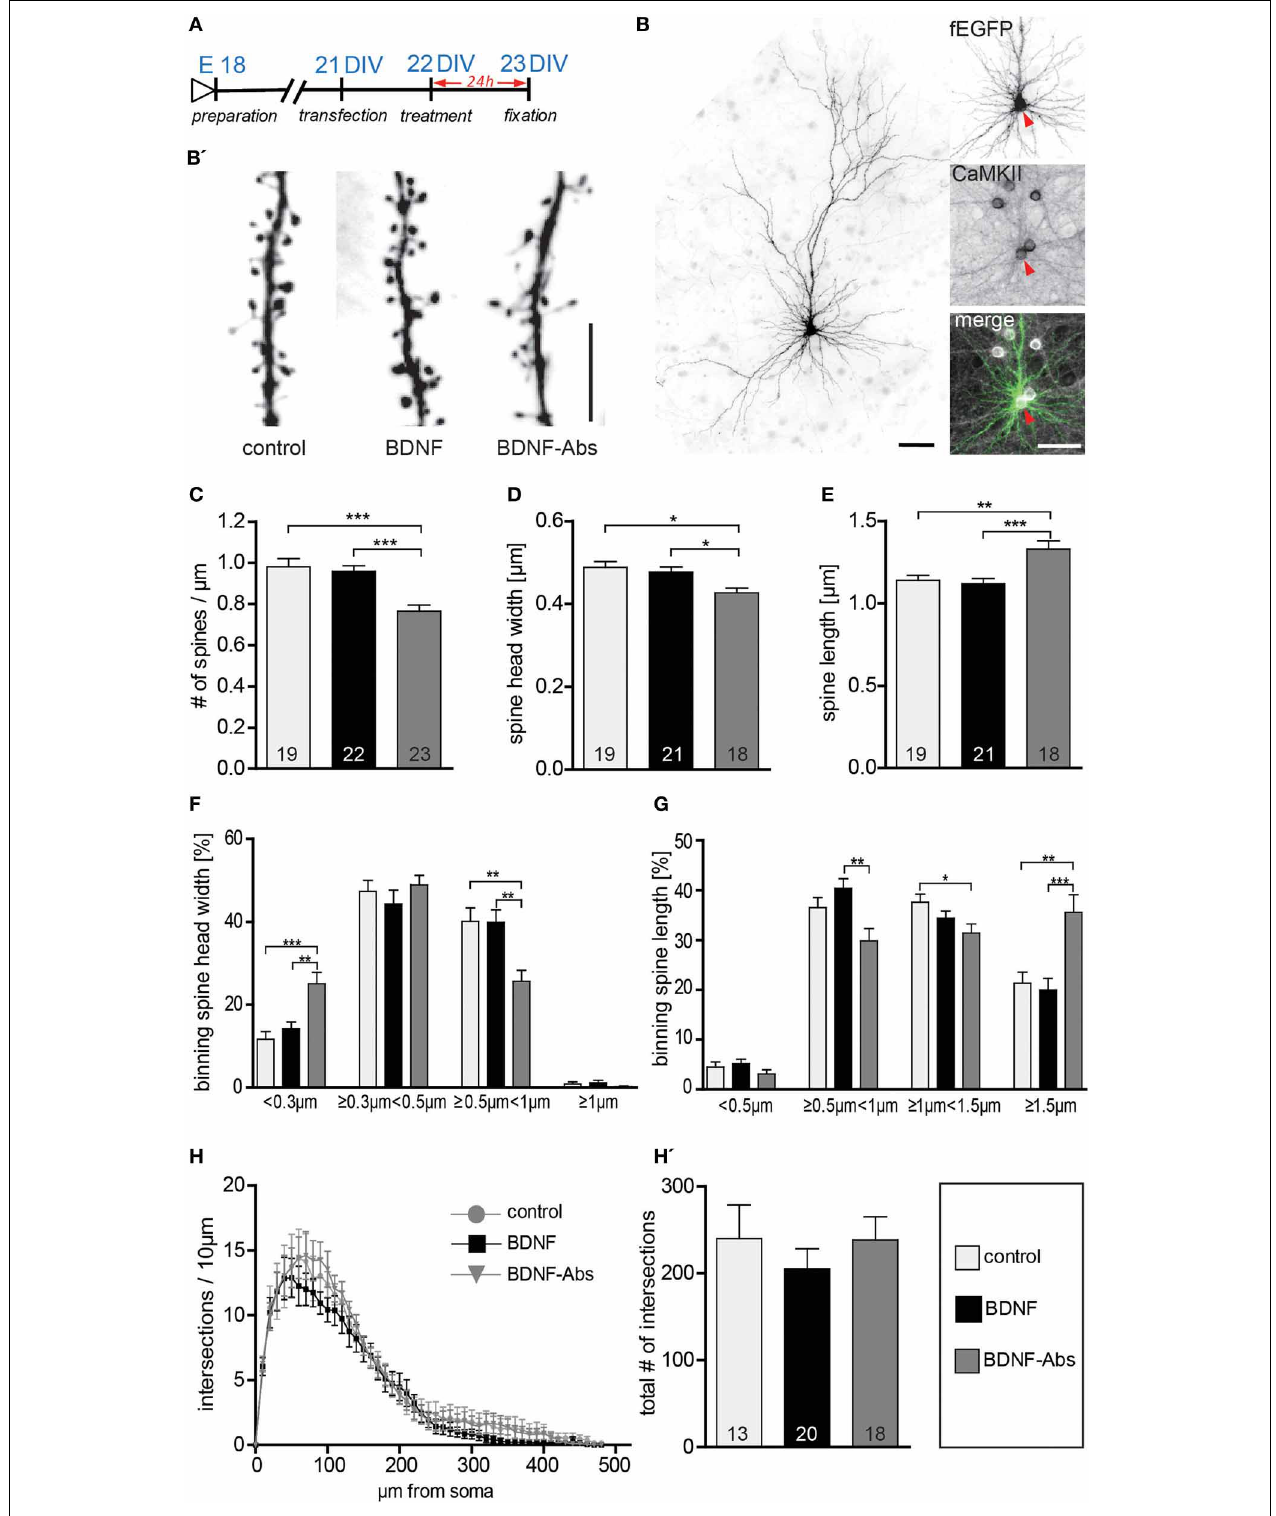
FIGURE 1 | (A) Experimental timeline. DIV23 hippocampal neurons were treated for 24h before fixation. (B) Representative image of a typical DIV23 fEGFP expressing hippocampal neuron used in the experiments; the inserts on the right show a close up of the cell body labeled with fEGFP (above) or